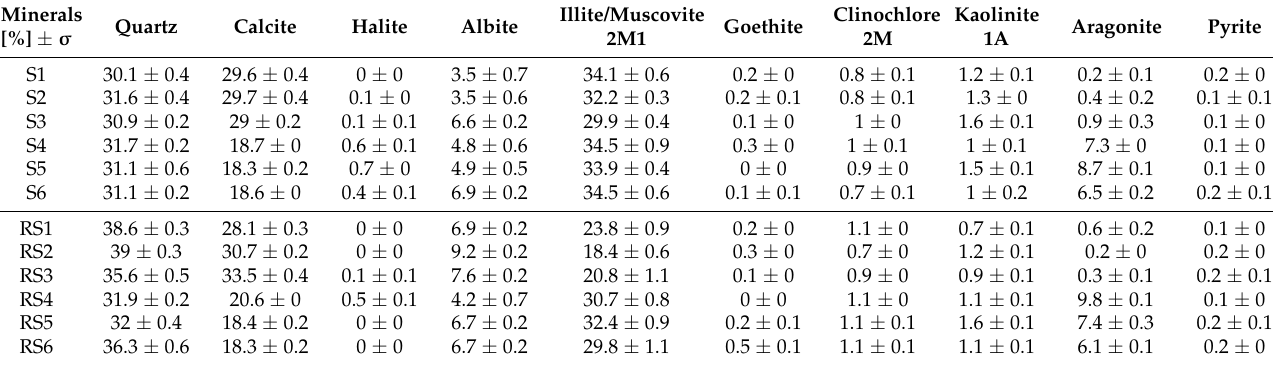
Figure 4. XRD patterns of the studied samples. Grey patterns represent the sediment samples and red patterns represent the rhizo-sediment samples. The uppercase letters describe the mineral composition of the samples. Table 3. Mineralogical composition of the investigated samples in